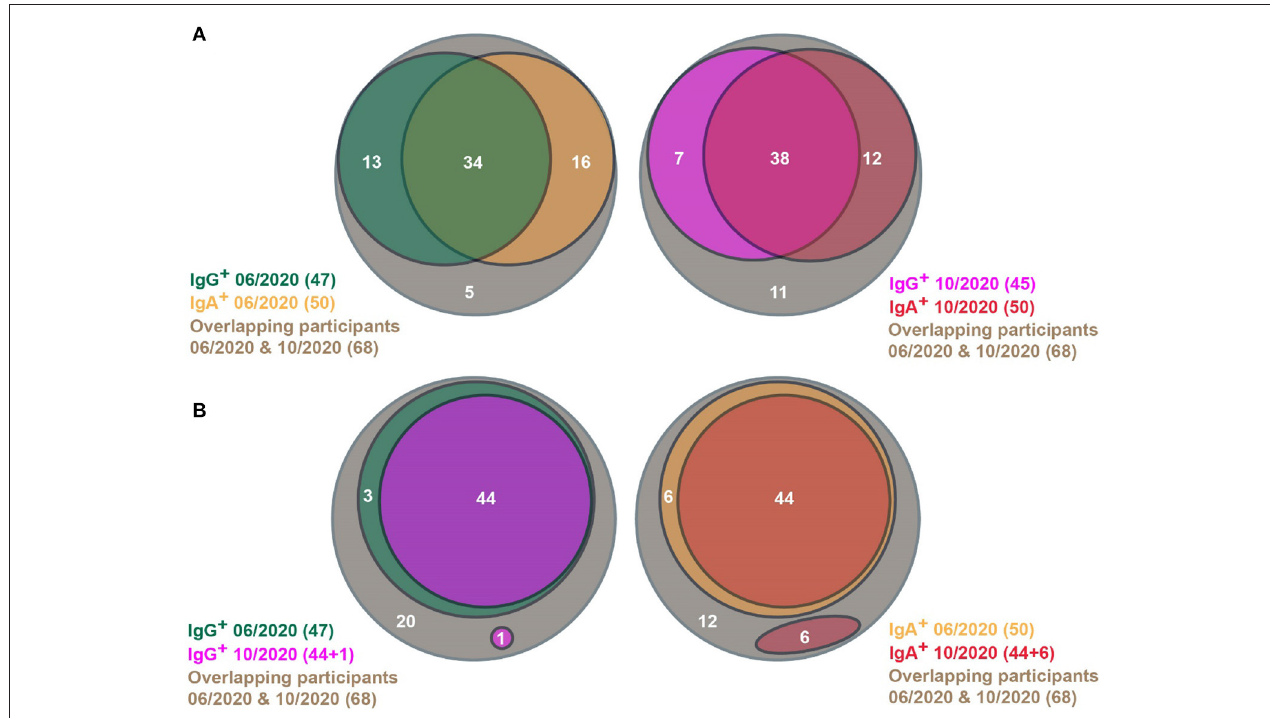
FIGURE 1 | Venn diagrams showing SARS-CoV-2-specific antibody prevalence in the pilot (06/2020) and the follow-up (10/2020) studies. (A) SARS-CoV-2-specific antibody status of participants in the pilot (left) and the follow-up studies (right), respectively. (B) Persistence of SARS-CoV-2-specific IgG (left) and IgA antibodies (right), respectively, between the pilot and the follow-up studies. (A,B) Only people were considered, who participated in both